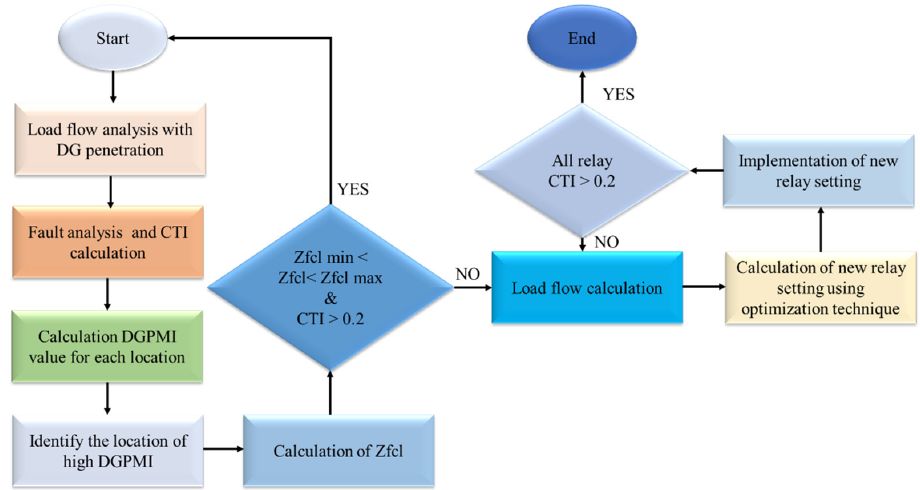
Figure 1. Proposed adaptive and non-adaptive hybrid protection scheme for dynamic relay operation.